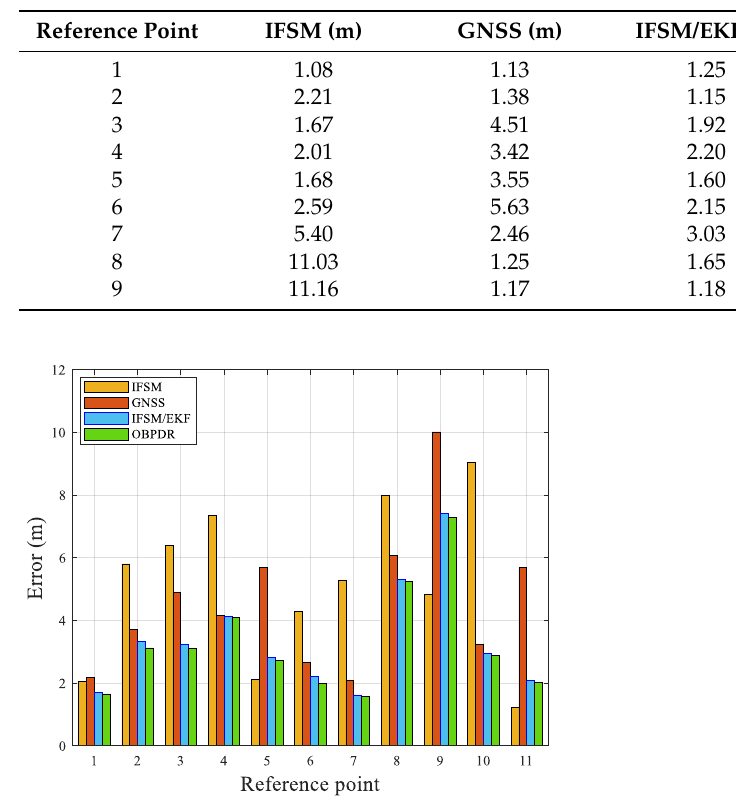
Figure 15. The statistical results of position errors in fountain experiment.